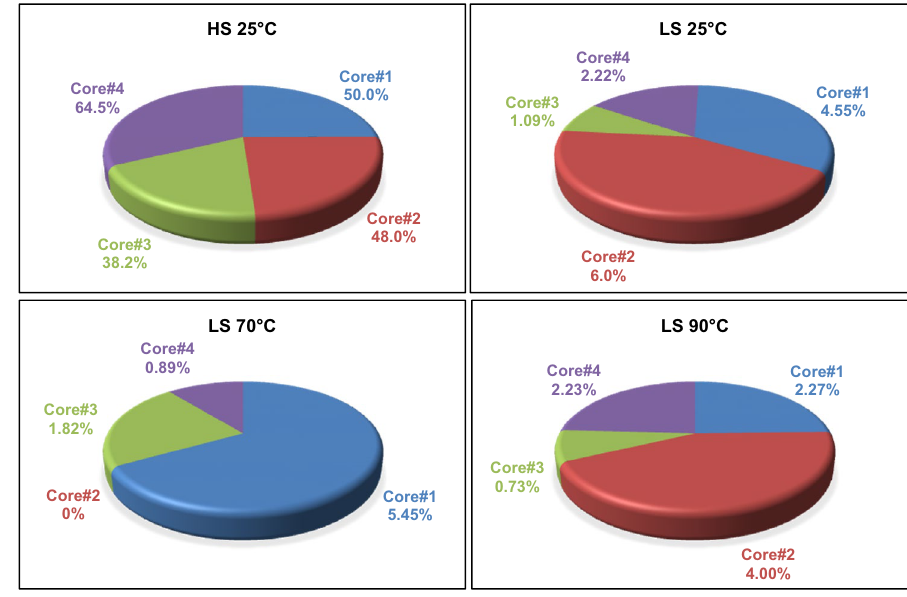
Fig. 13 Comparison in terms of ultimate oil recovery for all cores at 25, 70, and 90 °C